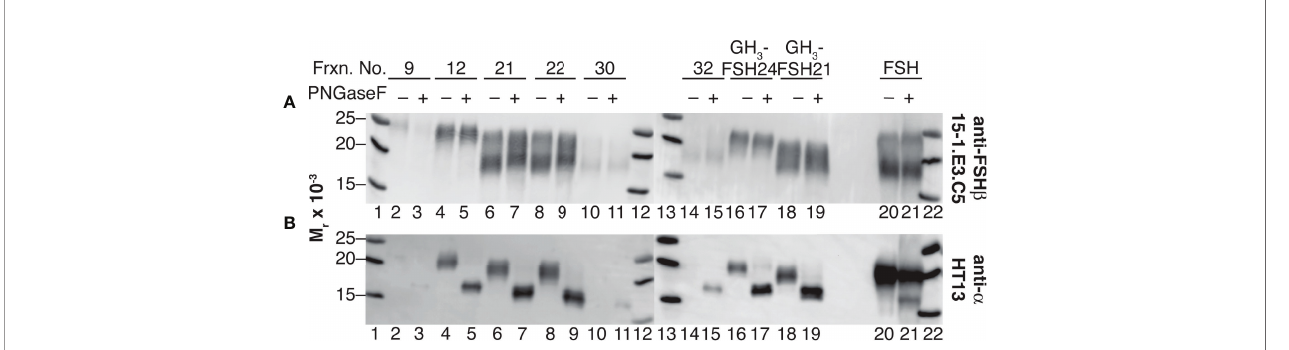
FIGURE 5 | Selective a Asn 52 deglycosylation of dissociated hFSH samples by PNGaseF digestion. Subunit mobilities were assessed by subunit-speci fi c Western blots of 1 µg samples of FSH dissociated into subunits and transferred to 0.2 M ammonium bicarbonate buffer by ultra fi ltration (see Methods). (A) FSH b probed with anti-FSH b monoclonal antibody 15-1.E3.E5 diluted 1:500. (B) FSH a probed with anti- a subunit monoclonal antibody HT13, diluted 1:5000. Lane 1, MW marker; lane 2, fraction 9 subunits; lane 3, fraction 9 subunits following PNGaseF digestion; lane 4, fraction 12 subunits; lane 5, fraction 12 subunits + PNGaseF; lane 6 subunits, fraction 21 subunits; lane 7, fraction 21 subunits + PNGaseF; lane 8, fraction 22 subunits; lane 9, fraction 22 subunits + PNGaseF; lane 10, fraction 30 subunits; lane 11, fraction 30 subunits + PNGaseF; lane 12, MW marker, lane 13, MW marker; lane 14, fraction 32 subunits; lane 15, fraction 32 subunits + PNGaseF; lane 16, recombinant GH 3 -FSH24 subunits; lane 17, GH 3 -FSH24 subunits + PNGaseF; lane 18,GH 3 -FSH21 subunits; lane 19, GH 3 -FSH21 subunits + PNGaseF; lane 20, intact hFSH; lane 23, intact hFSH + PNGaseF; lane 24, BioRad MW